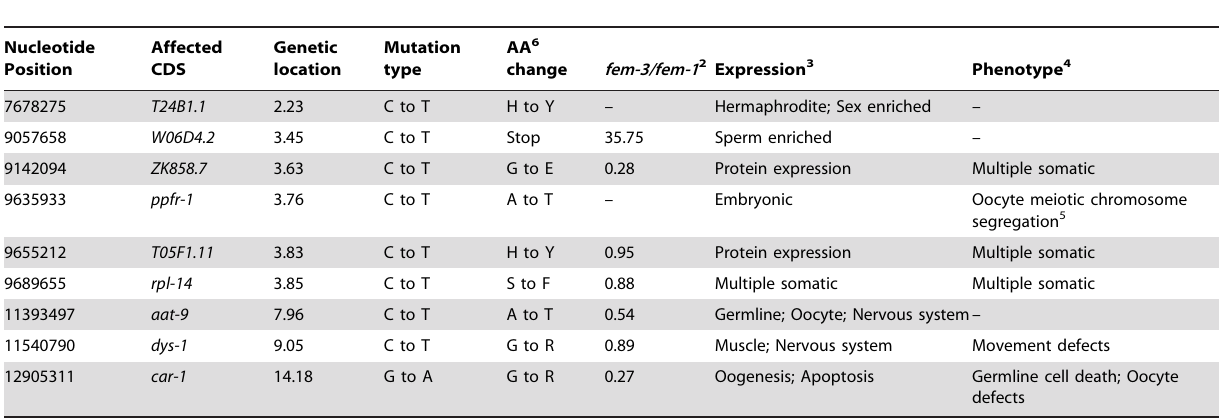
Table 1. Novel 1 non-synonymous mutations on Chromosome